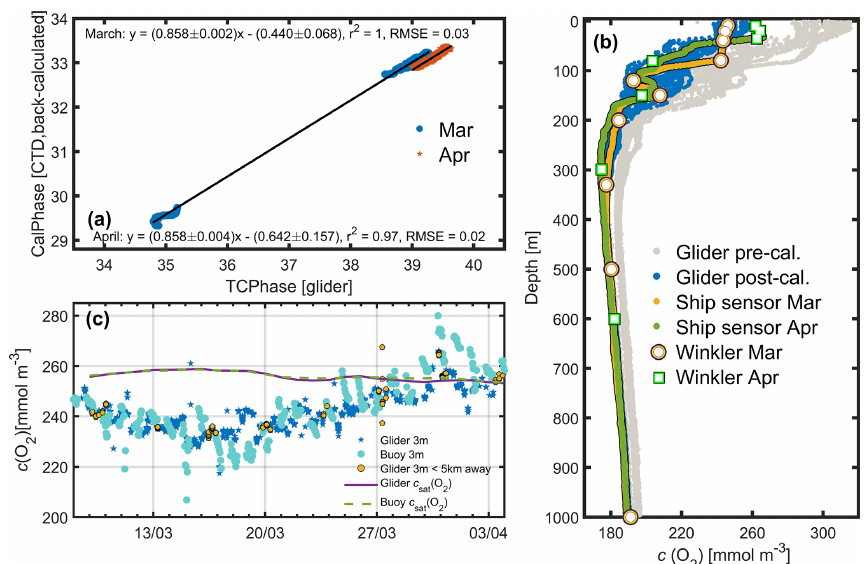
Figure B1. Calibration of the glider dissolved oxygen concentration ( c( O 2 ) ) sensor. (a) The linear regression fit using back-calculated ship pseudo-CalPhase and glider TCPhase for 7 March (blue) and 16 April (orange), along with the corresponding linear equations, r 2 and root- mean-squared errors (RMSE). The 95% confidence bounds are also shown. (b) Glider c( O 2 ) measured on 8–9 March and on 3–4 April before (grey), and after (blue) calibration, the ship sensor c( O 2 ) on 7 March (yellow) and on 16 April (green), and the c( O 2 ) Winkler samples on 7 March (white with orange border) and on 16 April (white with green border). (c) All glider sensor c( O 2 ) at 3m depth (blue stars), < 5km away from the BOUSSOLE buoy only (turquoise spots) and glider c sat (purple line) are compared with the BOUSSOLE buoy sensor c( O 2 ) measurements (orange spots) at 3m depth and buoy c sat (green dashed